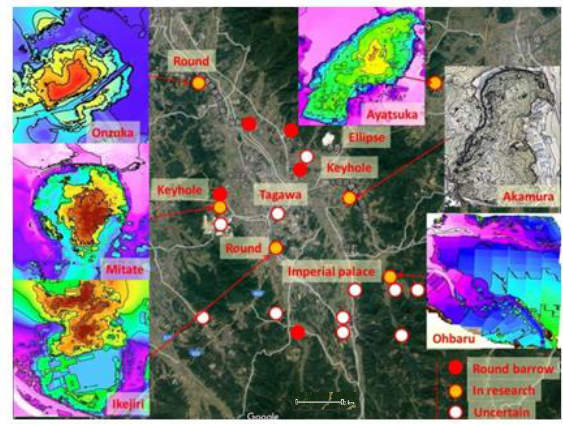
Figure 6. Spatial distribution of tombs in